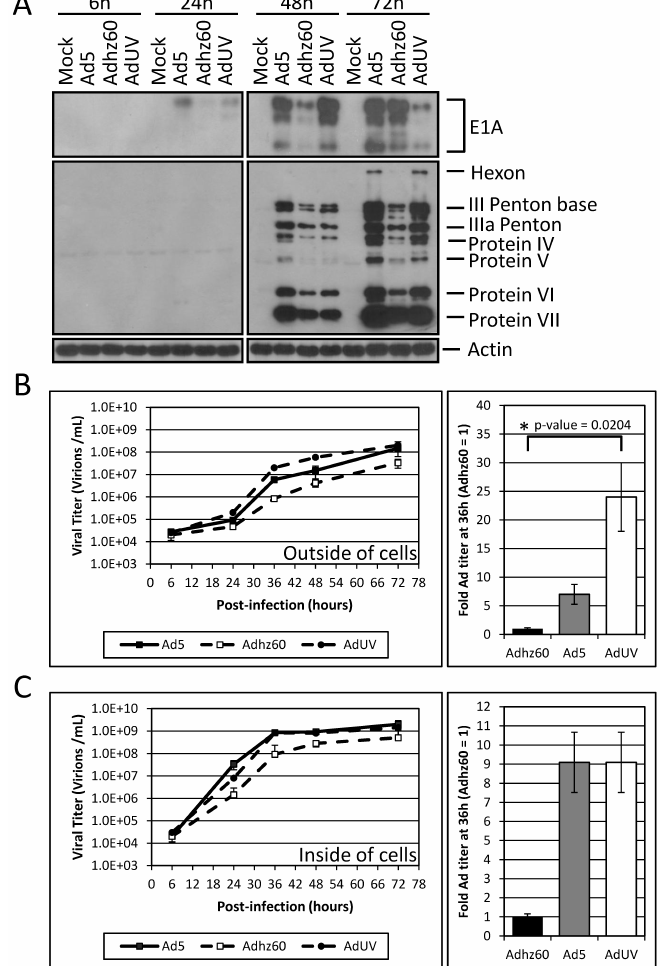
Figure 4. AdUV virus replication in A549 lung cancer cells. ( A ) The expression of the Ad E1A and late genes were observed in A549 cells treated with the indicated Ads at an MOI of 1 following 6 h, 24 h, 48 h, and 72 h infection; ( B ) Virus titer outside of A549 cells treated with the indicated Ads at an MOI of 1. Samples were collected at the indicated time-­‐‑points. At 36 h, the number of virions of released in the cell culture media was seven-­‐‑fold for Ad5 and 24-­‐‑fold for AdUV when normalized to Adhz60 titer; ( C ) Virus titer inside of infected A549 cells treated with the indicated Ads at an MOI of 1. Samples were collected at the indicated time-­‐‑points. At 36 h, the titers of AdUV and Ad5 inside of cells were nine-­‐‑fold of Adhz60. Data is presented as the average titer ± the standard deviation (SD) of three independent replicates. Significance was determined via the Kruskal-­‐‑Wallis test. Adjusted p -­‐‑values were reported for multiple comparisons via Dunn’s test. h indicates hours, * indicates p -­‐‑value < 0.05.